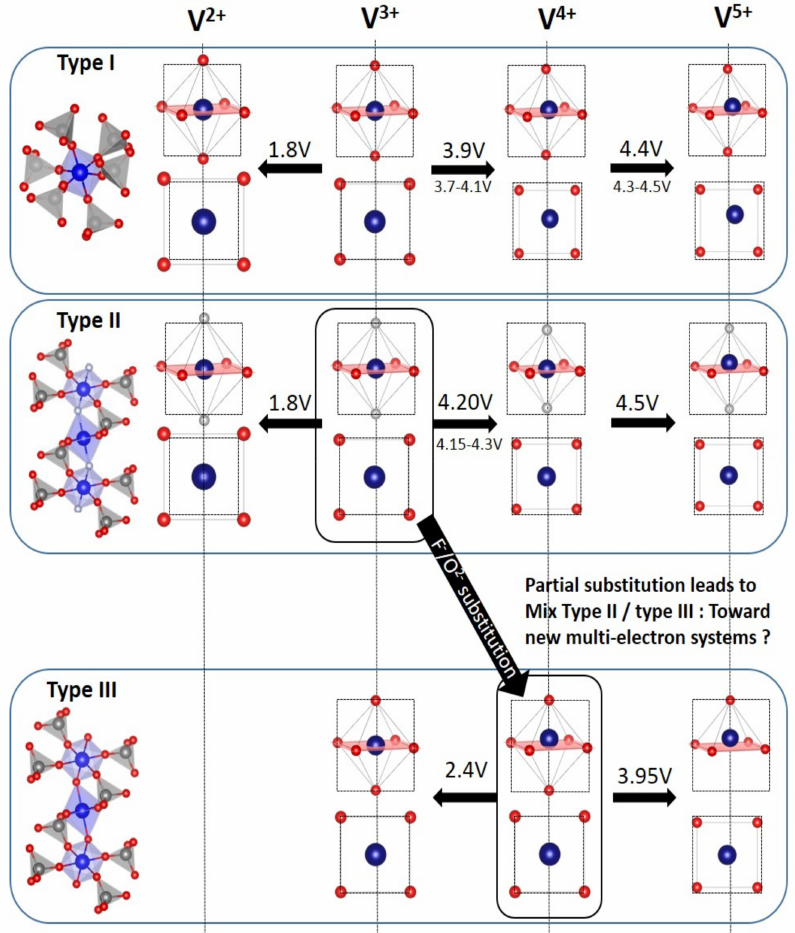
Figure 14. Typical evolution of vanadium environments according to the oxidation state of vanadium for type I, type II and type III